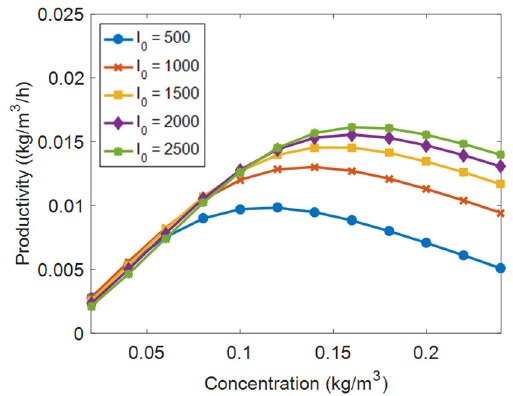
Figure 7. Biomass productivity varying with algal concentration and incident light intensity I 0 [μE/m 2 s] for air inlet flowrate of 0.5 L/min, using the steady state growth model and the Standard Design of the PBR.